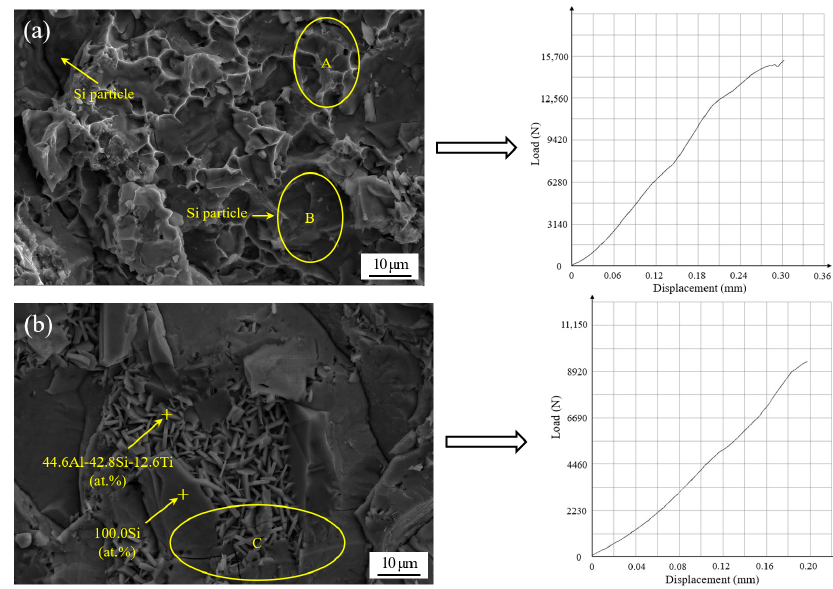
Figure 12. Scanning fracture appearance and corresponding shear curve of the joints brazed at temperature of 580 °C and time of 30 min with different brazing filler metals: ( a ) Al-7.5Si-23.0Cu-2.0Ni-1.0Ti; ( b )